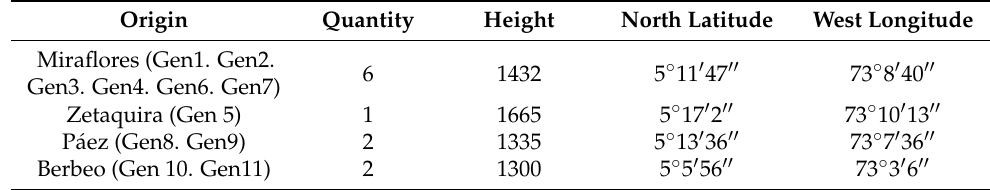
Table 3. Origin sites of the evaluated of yellow pitahaya in the Department of Boyac á